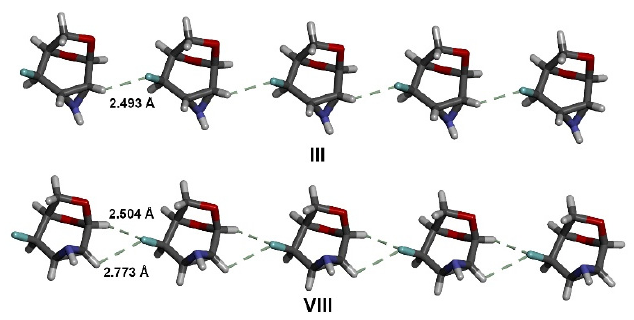
Figure 14. A chain formation in the structures III ( top ) and VIII ( bottom ).